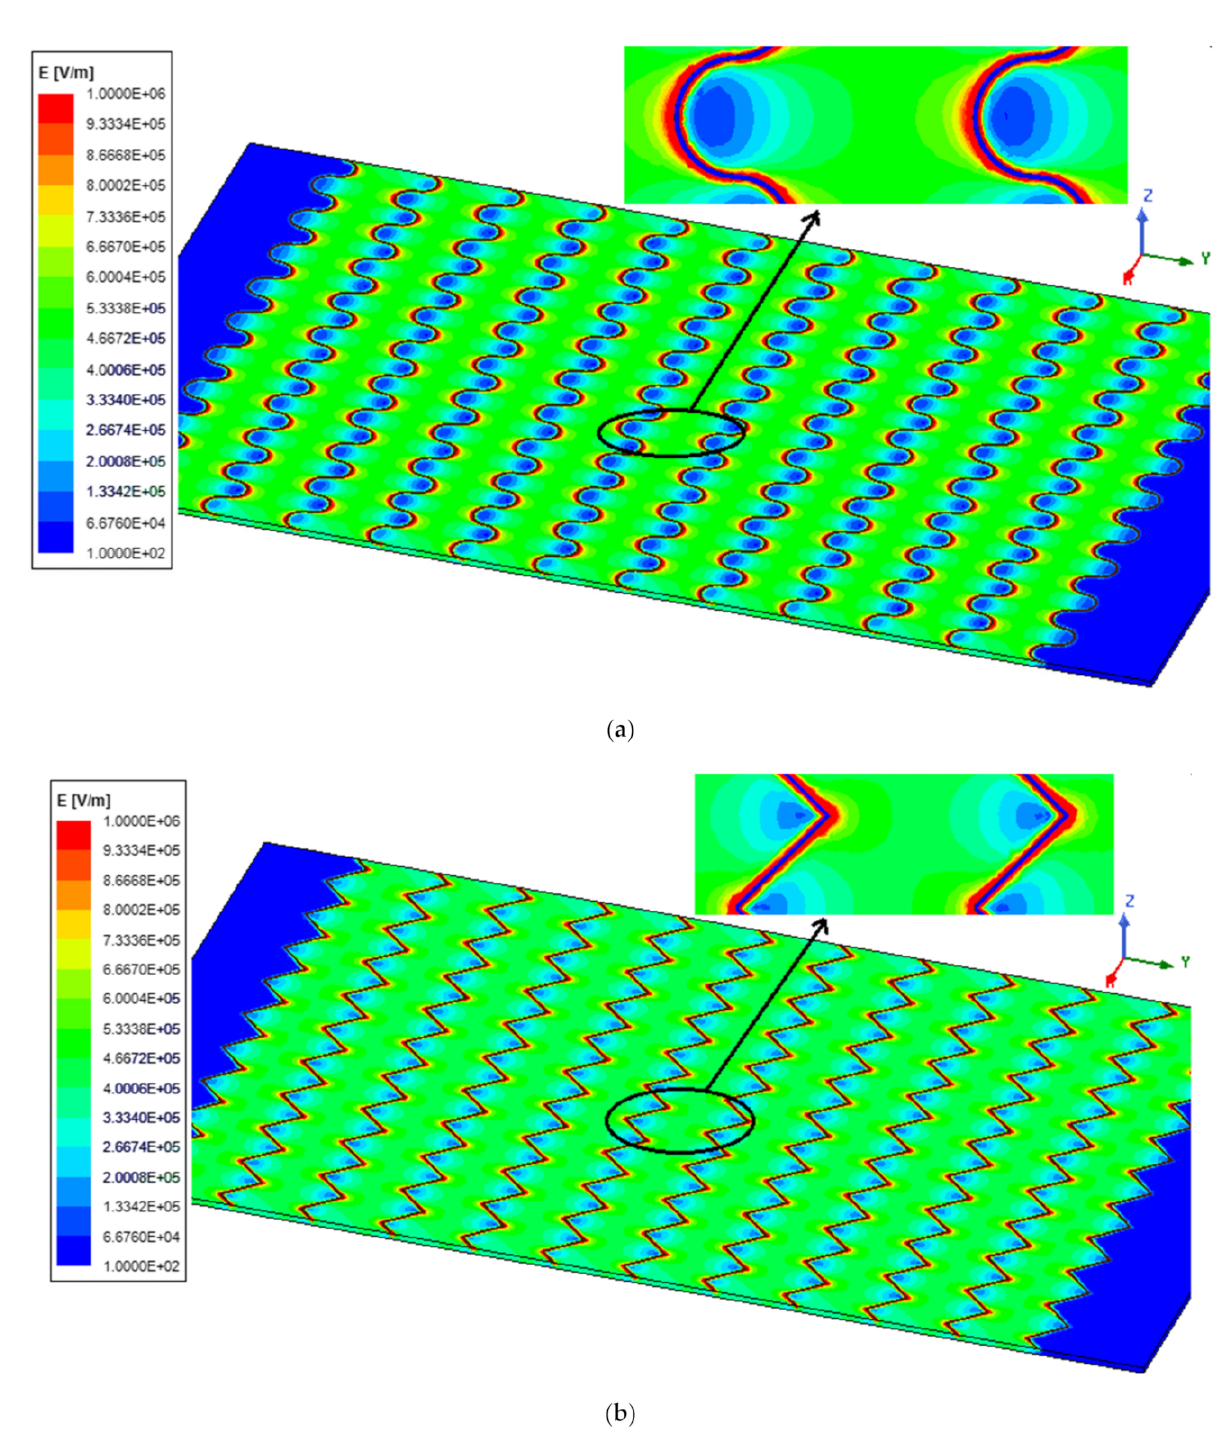
Figure 4. 3D FEA electric field distribution: ( a ) M3 model; ( b ) M4 model. M1 has a uniform electric field distribution, while M2 is little different from a uniform electric field. Note also that the distribution of the electric field between the top and bottom of the plate is not uniform. Figures 5 and 6 show the magnitude of the distribution in detail along three lines passing along the main axis of the panel from top to